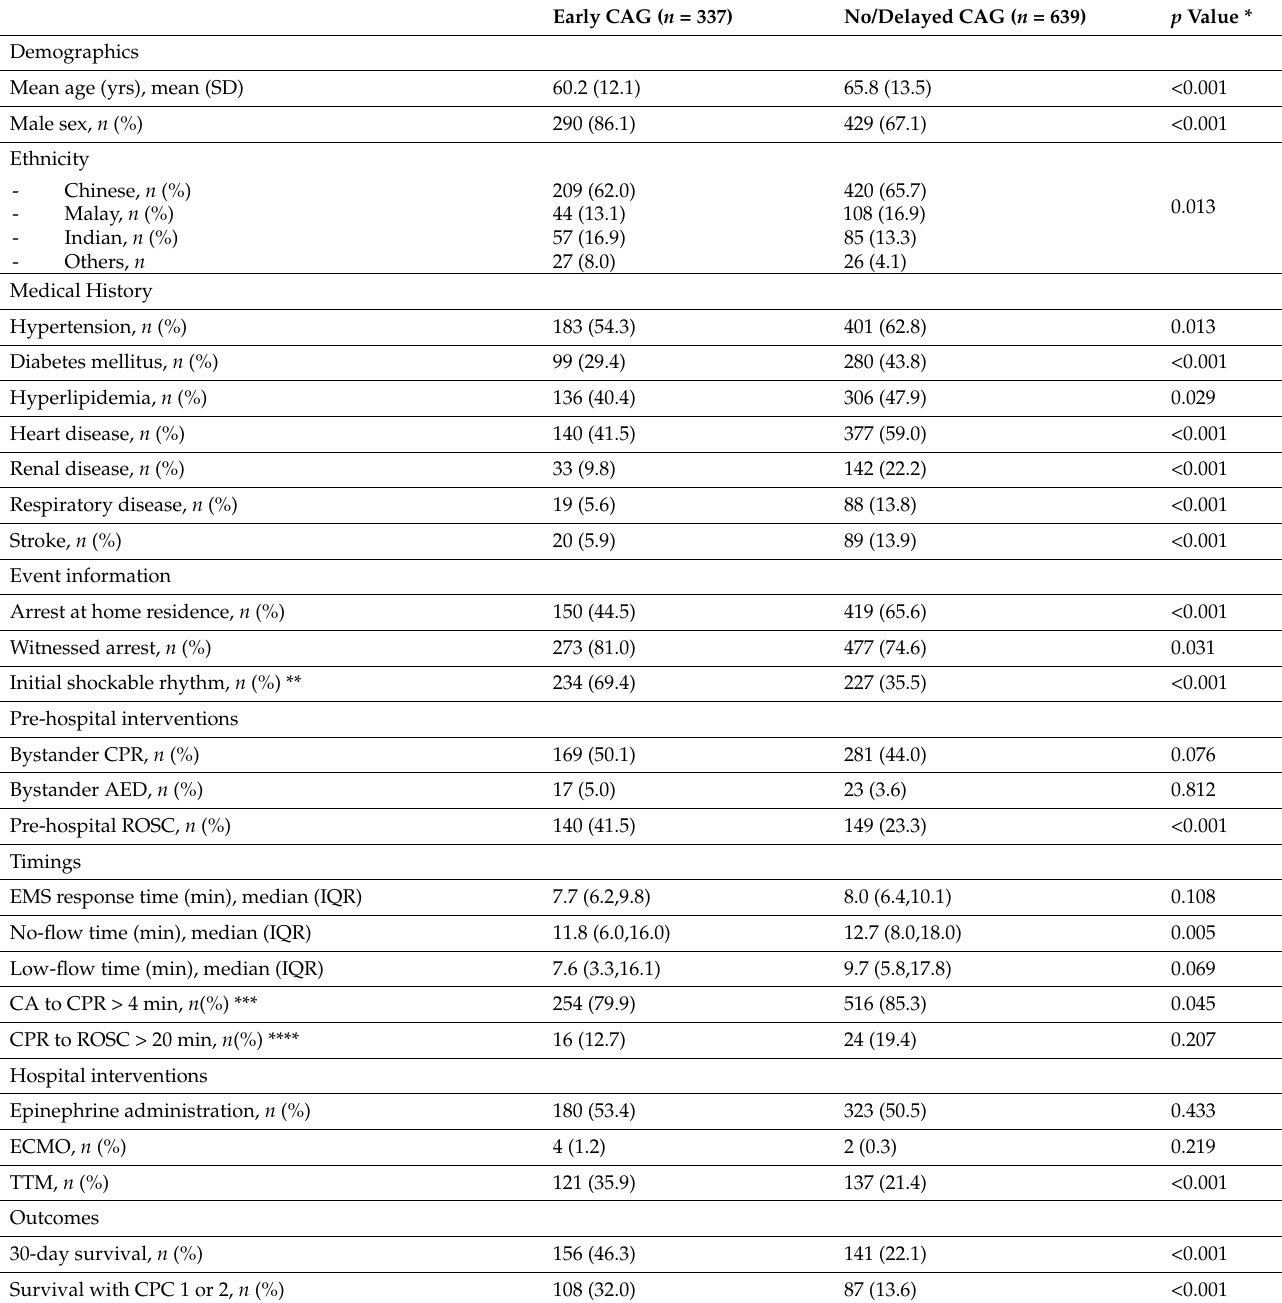
Table 1. Characteristics of resuscitated adult OHCA patients of presumed cardiac